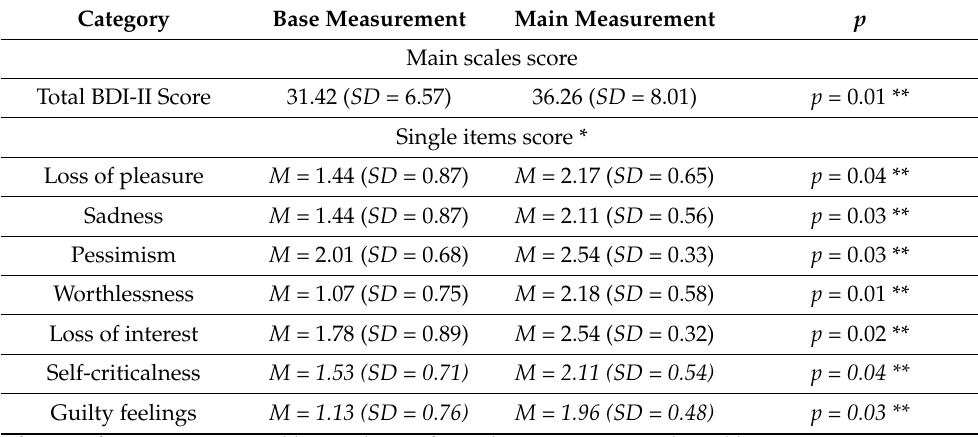
Table 4. Comparison of scores in scales and single items of the BDI-II between the base and main measurement in a group of depressed